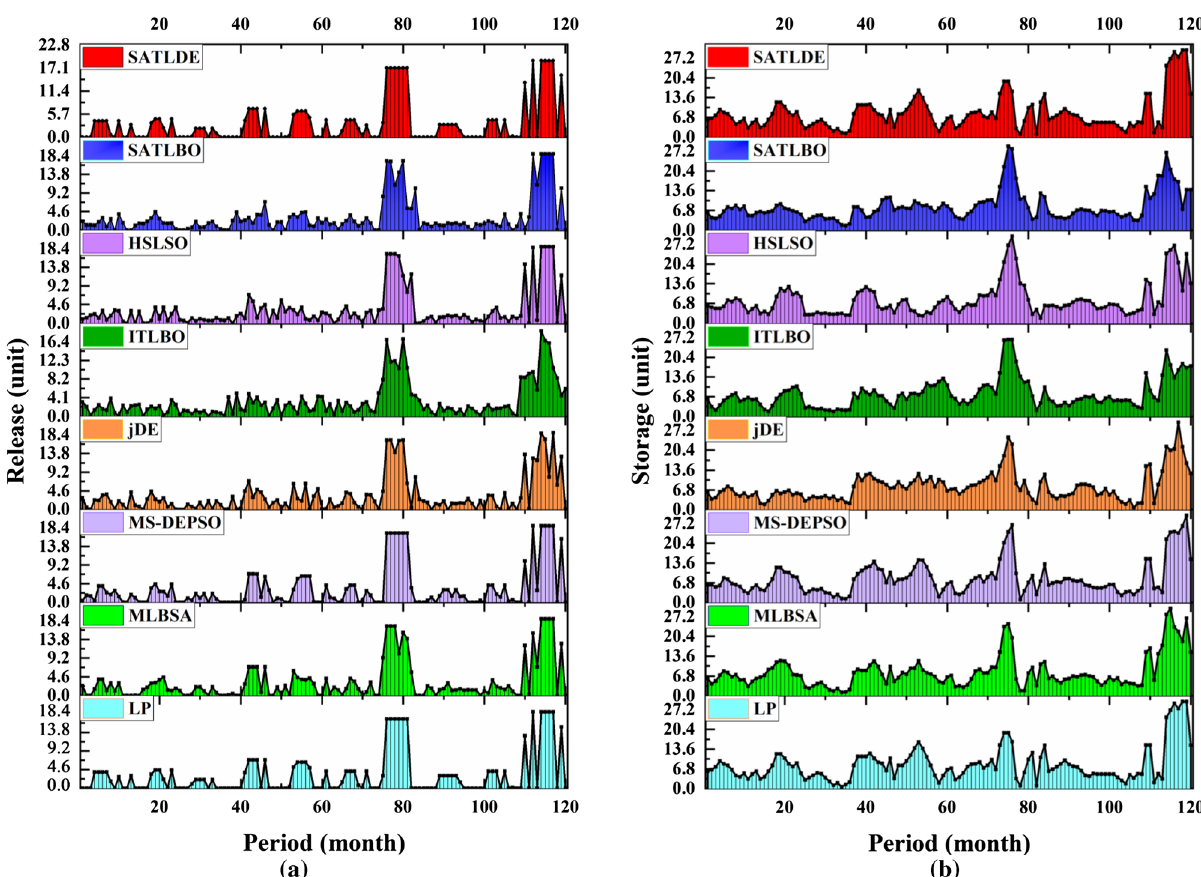
Figure 9. Reservoir volumes for ten-reservoir problem at two modes: ( a ) storage, ( b ) release.